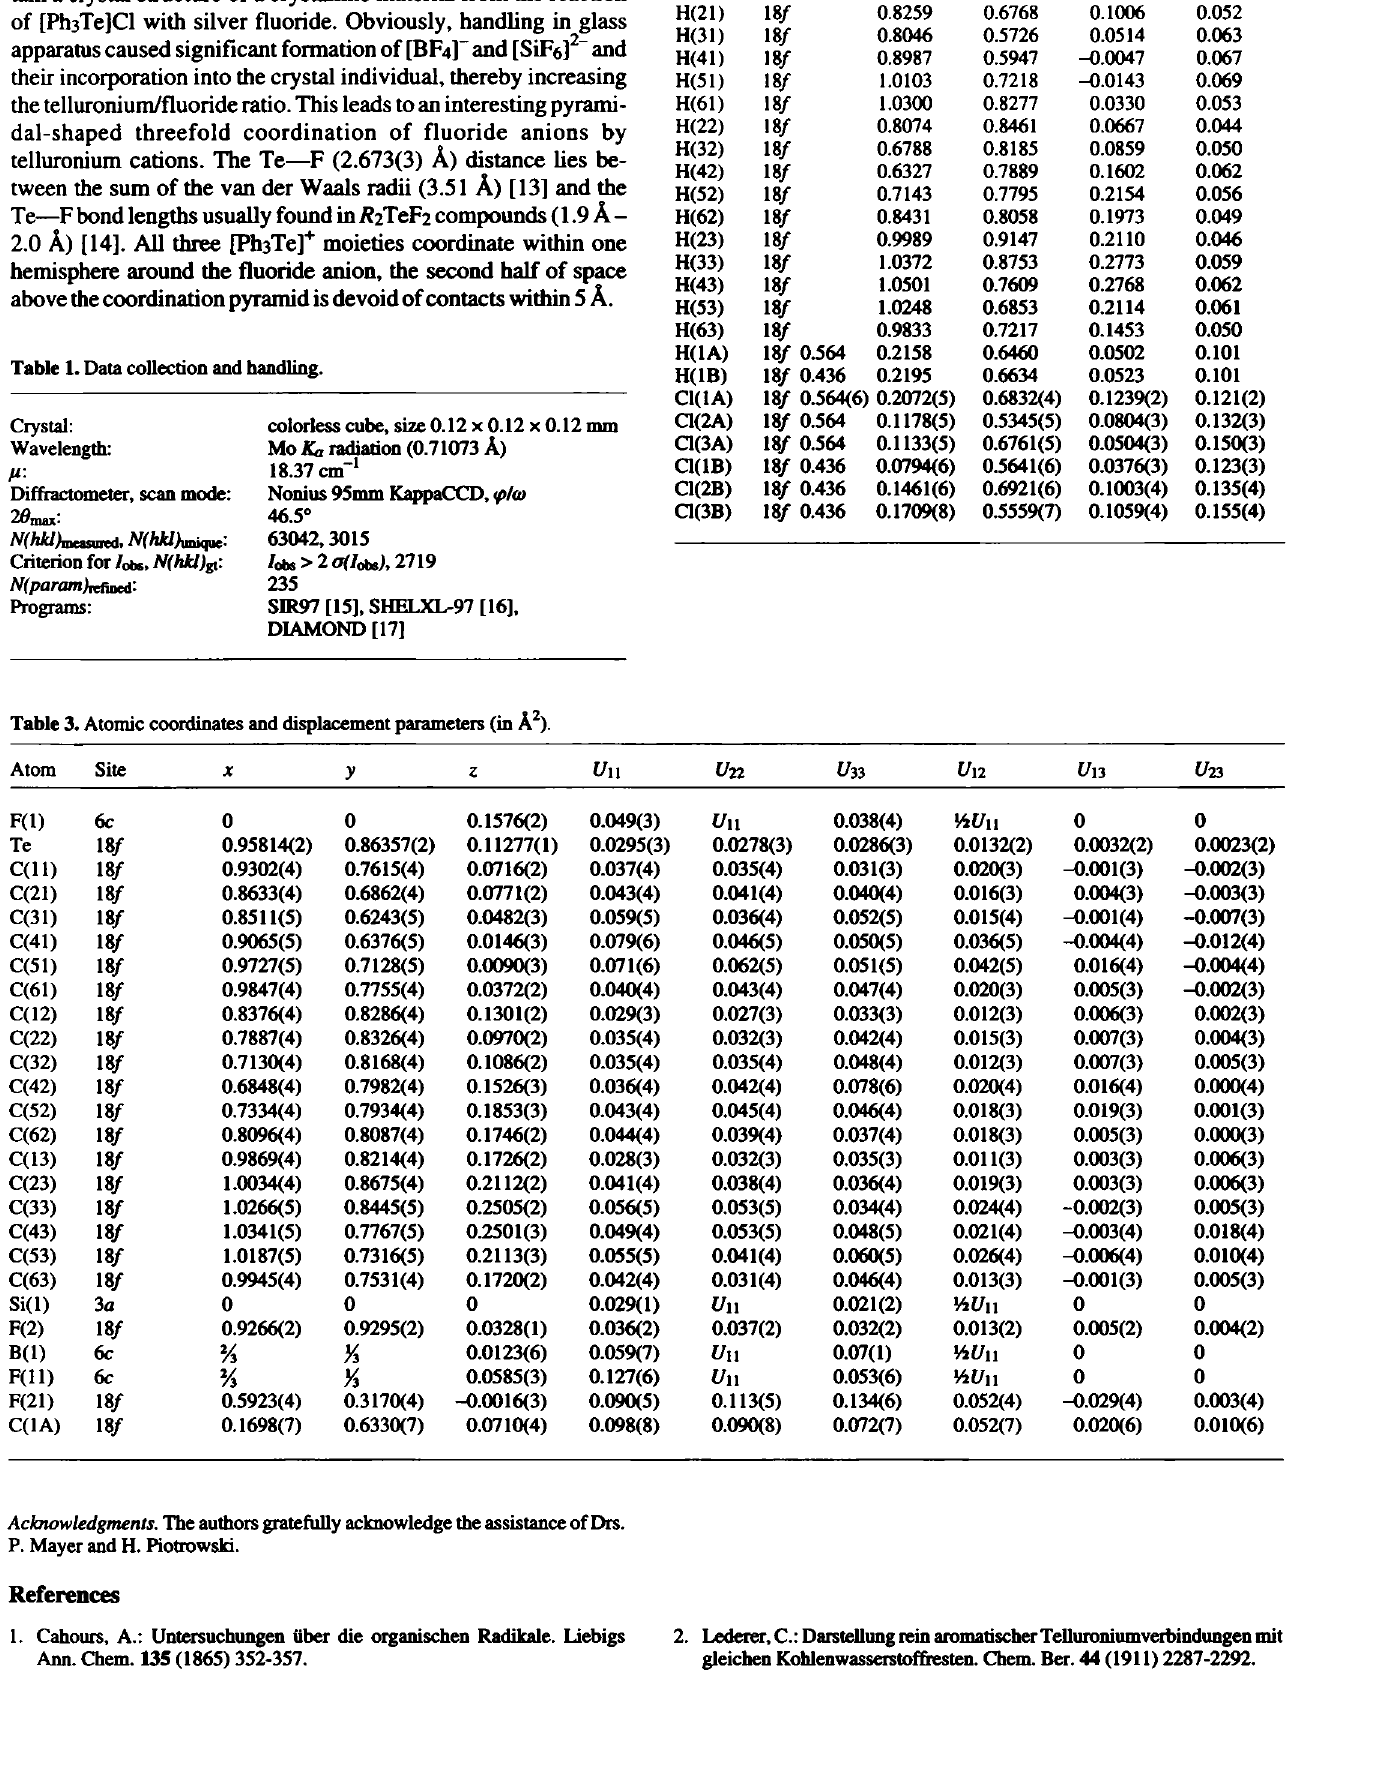
Table 1. Data collection and handling.